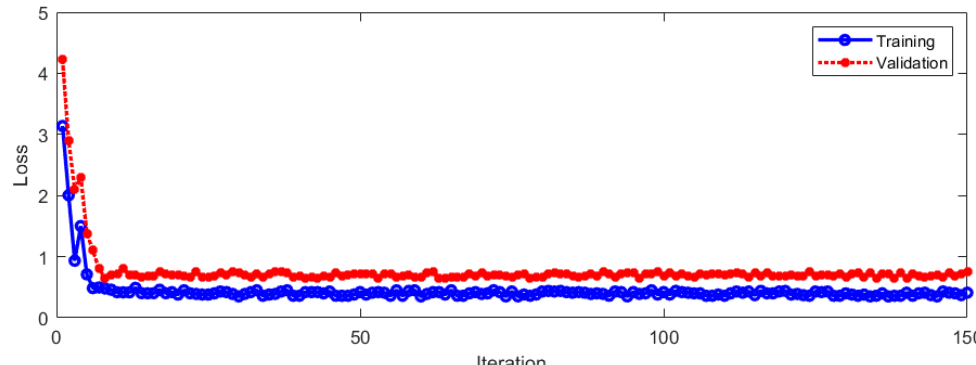
Figure 10. Training and verification of the model. The LOSS of the model during training and verification is shown in Figure 11.